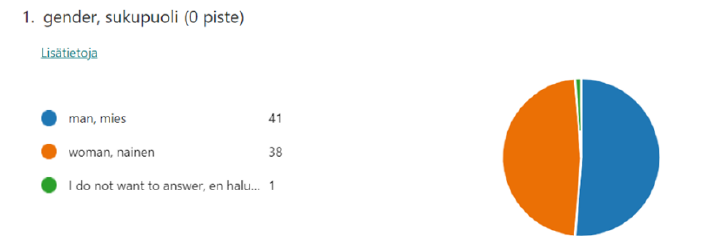
Figure 1. Gender division of the respondents. Source: (Authors’ elaboration).